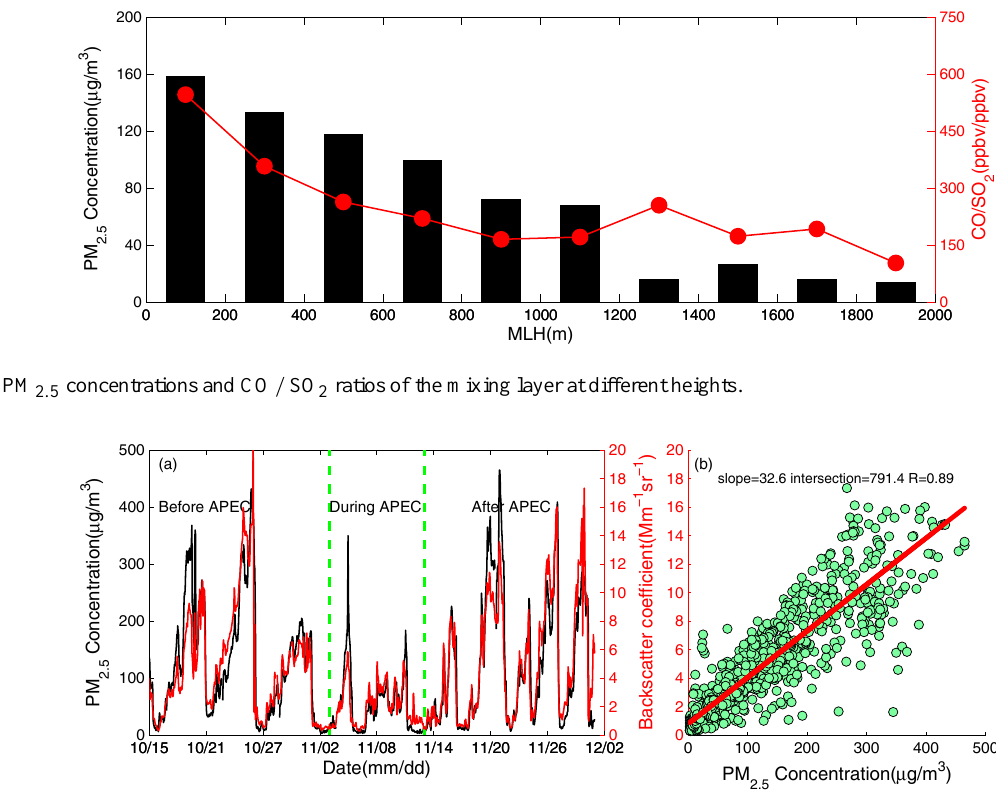
Figure 4. PM 2 . 5 concentrations and attenuated backscattering coefficients vs. time (a) and their correlations (b) from 15 October to 30 November